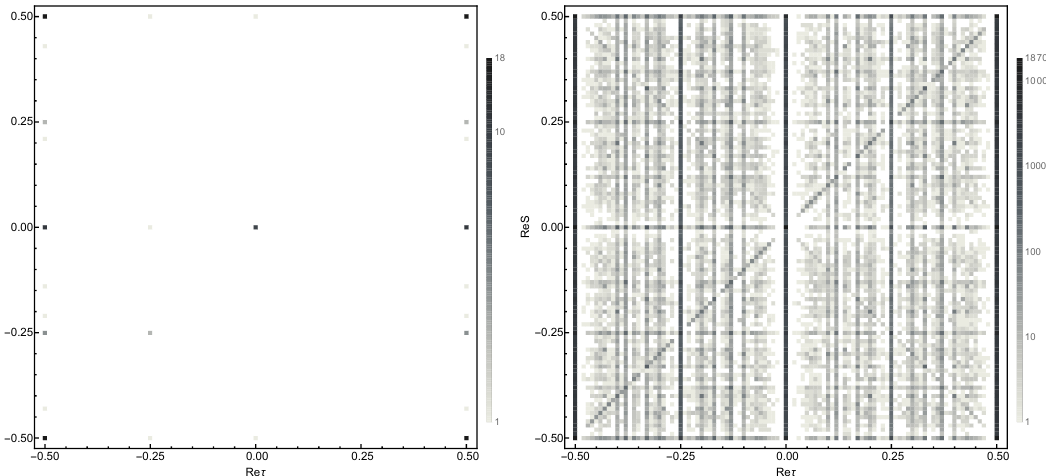
Figure 3 . The numbers of stable vacua on the (Re (cid:28); Re S ) plane for N max and N max = 1000 in the right panel, (cid:13)ux